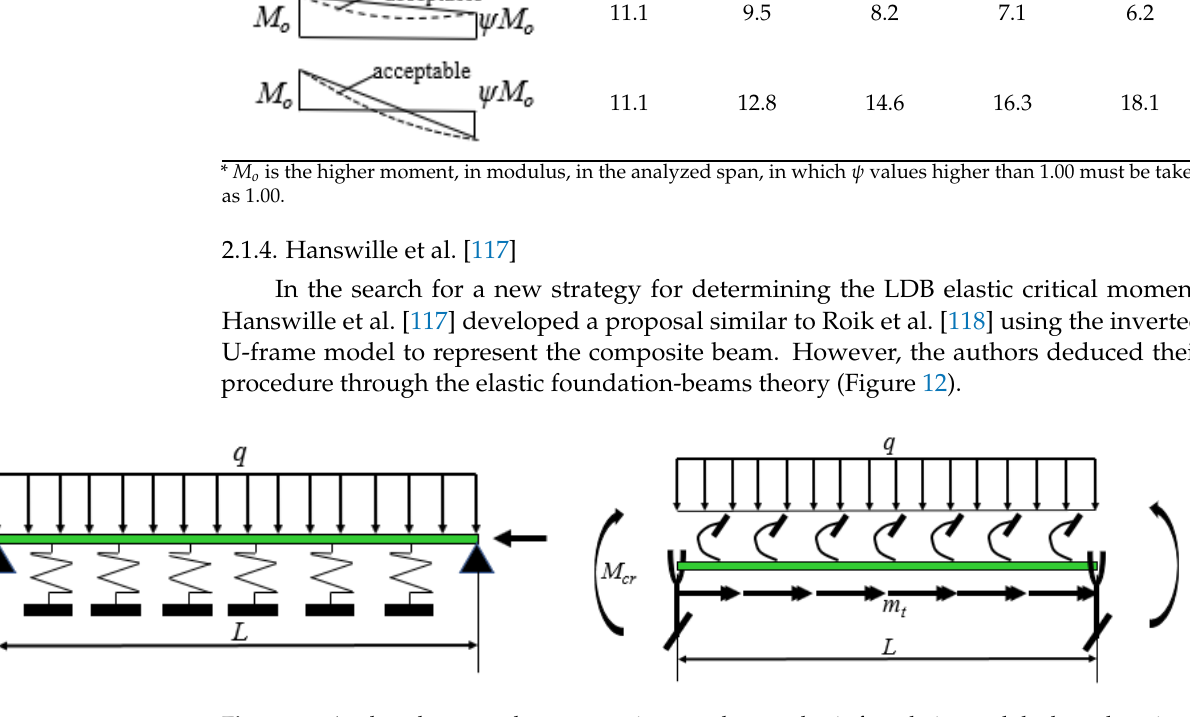
Figure 12. Analogy between the compression member on elastic foundation and the lateral torsional buckling problem. Adapted from